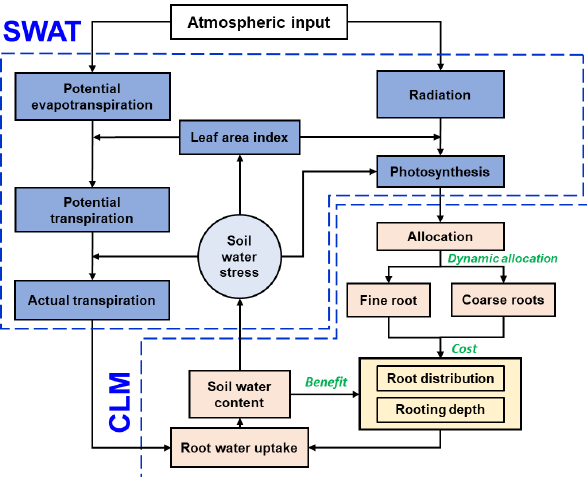
Figure 1. The model structure integrated from the SWAT (blue boxes) and CLM (light orange boxes) components. The root growth module is highlighted in yellow, and the descriptions of the dynamic fine-root distribution and rooting depth approach are illustrated us- ing green